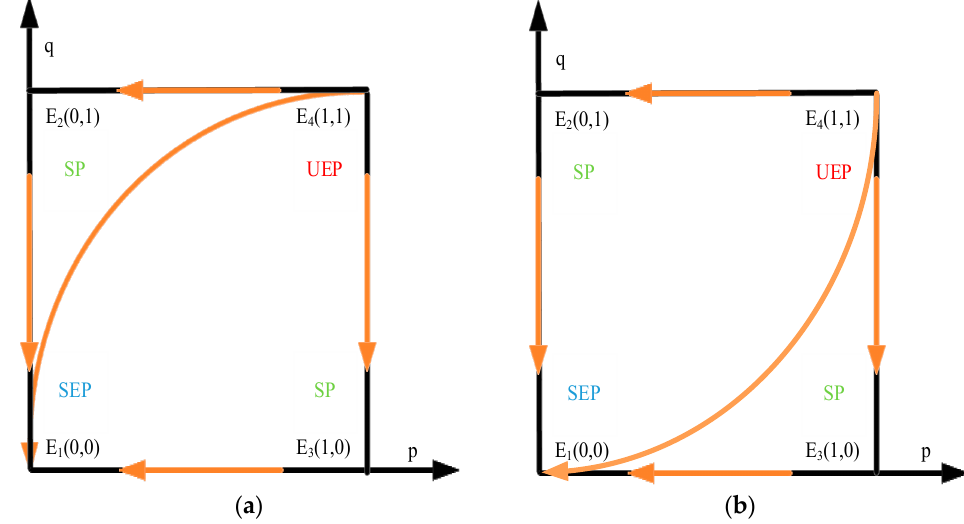
Figure 1. The evolution trend of power generation bidding under scenario 1.1-a. ( a ) Trend diagram of the dynamic evolution under condition 1, ( b ) Trend diagram of the dynamic evolution under condition 2.